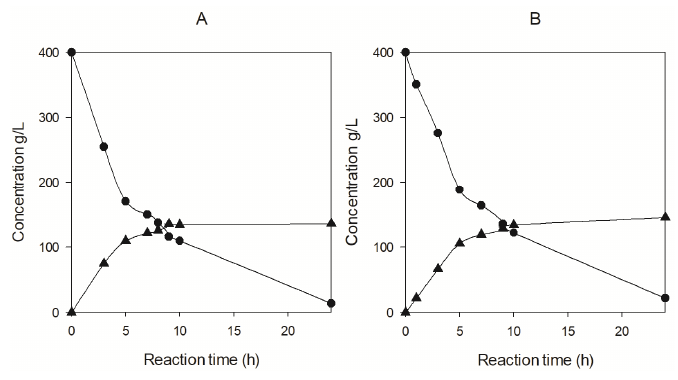
Figure 3. Kinetics of GOS formation at 15 U/mL and pH 7.5, using 400 g/L lactose catalyzed by P. anthophila permeabilized cells from: ( A ) Bac 55.2; ( B ) Bac 69.1: ( ● ) Lactose; ( ▲ ) Total GOS.